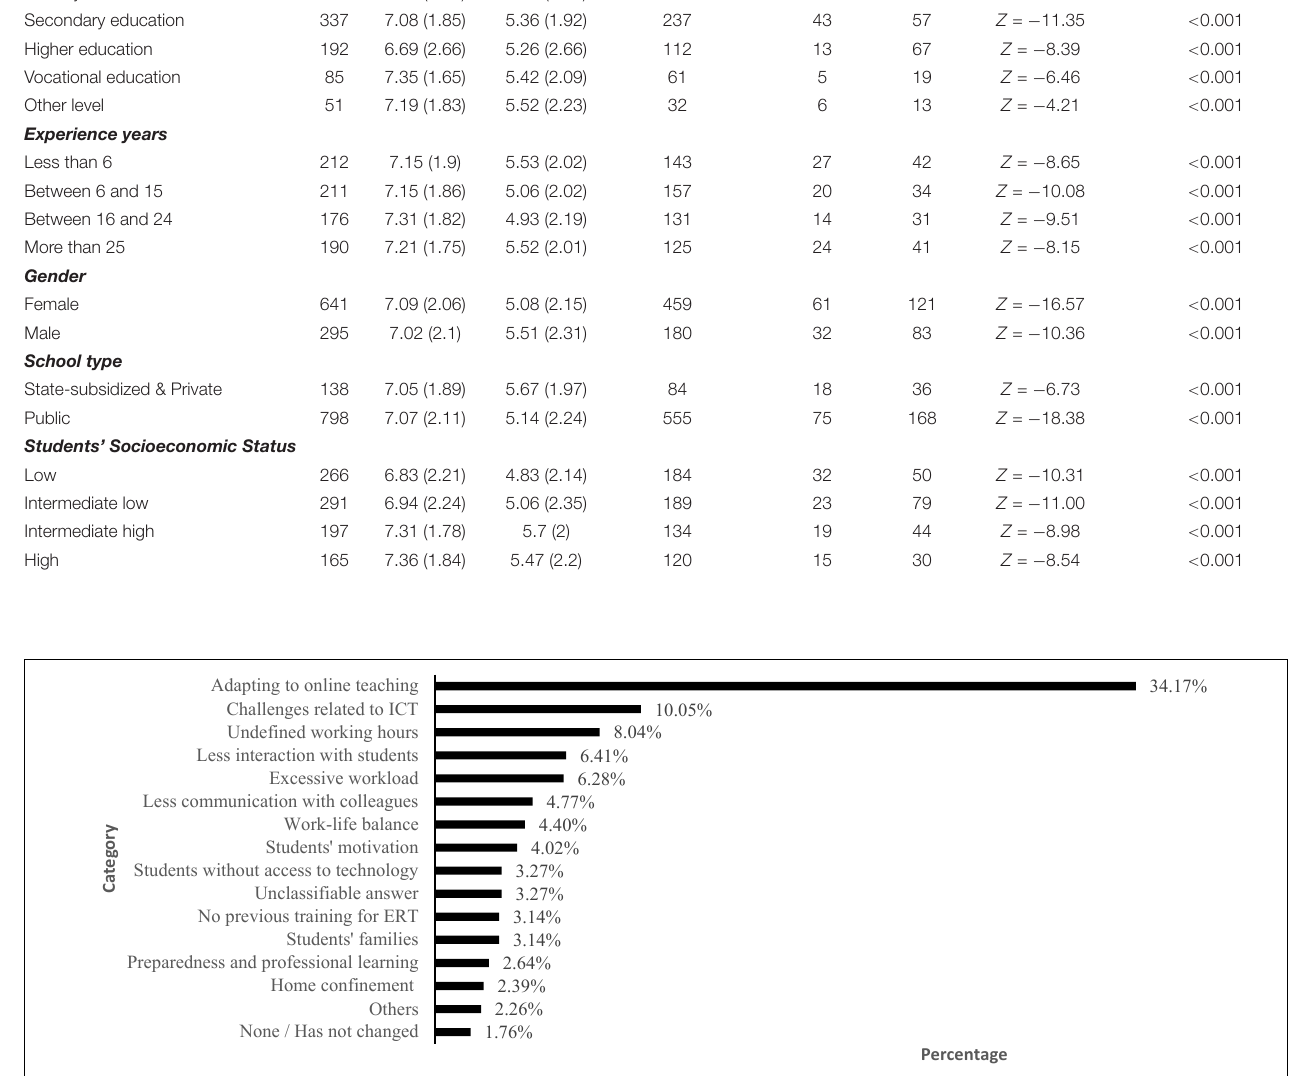
FIGURE 3 | Main challenges for teachers’ well-being ( n = 796). Adapting to online teaching includes reaching all students and teaching them efficiently (9.3%), remote teaching (5.15%), academic guidance and support (3.27%), lesson planning (2.39%), no teaching material (2.26%), coping uncertainty and stress (2.01%), providing/receiving feedback (2.01%), assessment (1.88%), working remotely (1.63%), excessive bureaucracy and paperwork (1.63%), nonconformity with lessons delivery (1.51%), and receiving students’ low-quality work (1.13%). Students’ families includes conflict with families (1.26%), criticism from families (1.01%), and adapting to families without resources (0.87%). Home confinement refers to not leaving home and